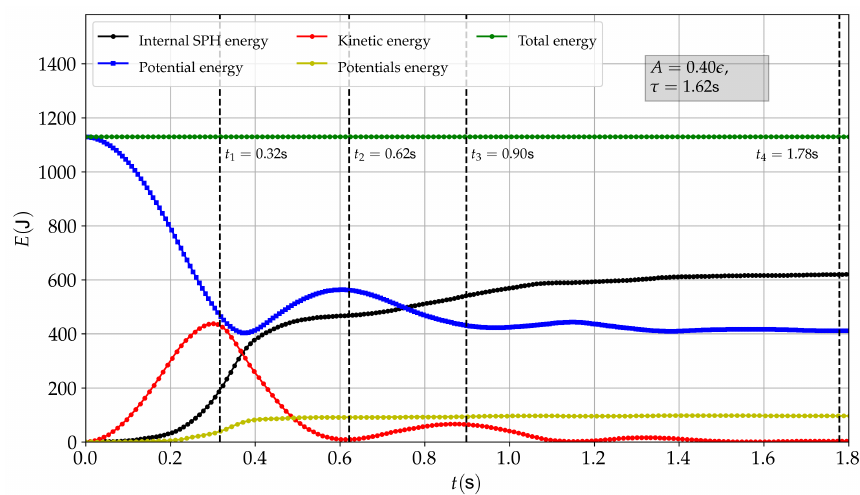
Figure 35. Energy budget vs. time for a “mostly” viscous substance. (cid:101) CS = 1 × 10 − 4 , A = 0.4 (cid:101) CS .